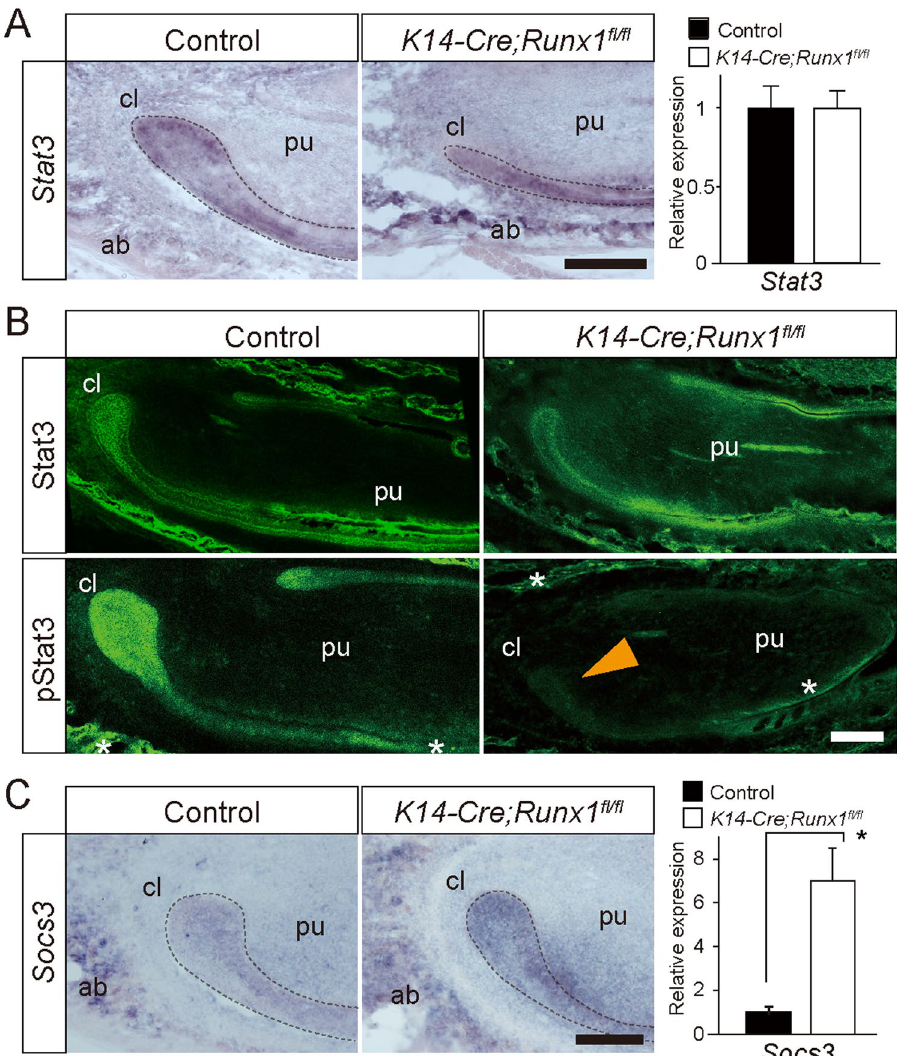
Figure 3. ( A ) An in situ hybridization analysis demonstrated that the mRNA expression of Stat3 was evident in the cervical loop and the alveolar bone in the Runx1 mutant and control mice. A qPCR demonstrated that the Stat3 expression was not affected significantly by Runx1 deficiency. Scale bar: 200 μ m. ( B ) Stat3 immunoreactivity was widely distributed in both the epithelium and the mesenchyme of the incisors and the surrounding bone. Stat3 immunoreactivity was not affected by Runx1 deficiency. In contrast, the pStat3 immunoreactivity of the cervical loop epithelium and the differentiating ameloblast was intense in control mice. In the Runx1 mutants, immunoreactivity to pStat3 was remarkably disturbed at the cervical loop epithelium (arrowhead), but not in the odontoblast layers or on the alveolar bone surface (asterisks). Scale bar: 200 μ m. ( C ) An in situ hybridization analysis demonstrated that the mRNA expression of Socs3 was evident in the cervical loop and upregulated in Runx1 mutants. A qPCR demonstrated that the Socs3 expression was significantly upregulated by Runx1 deficiency. Scale bar: 200 μ m. * p < 0.05. cl, cervical loop; pu, dental pulp; ab, alveolar